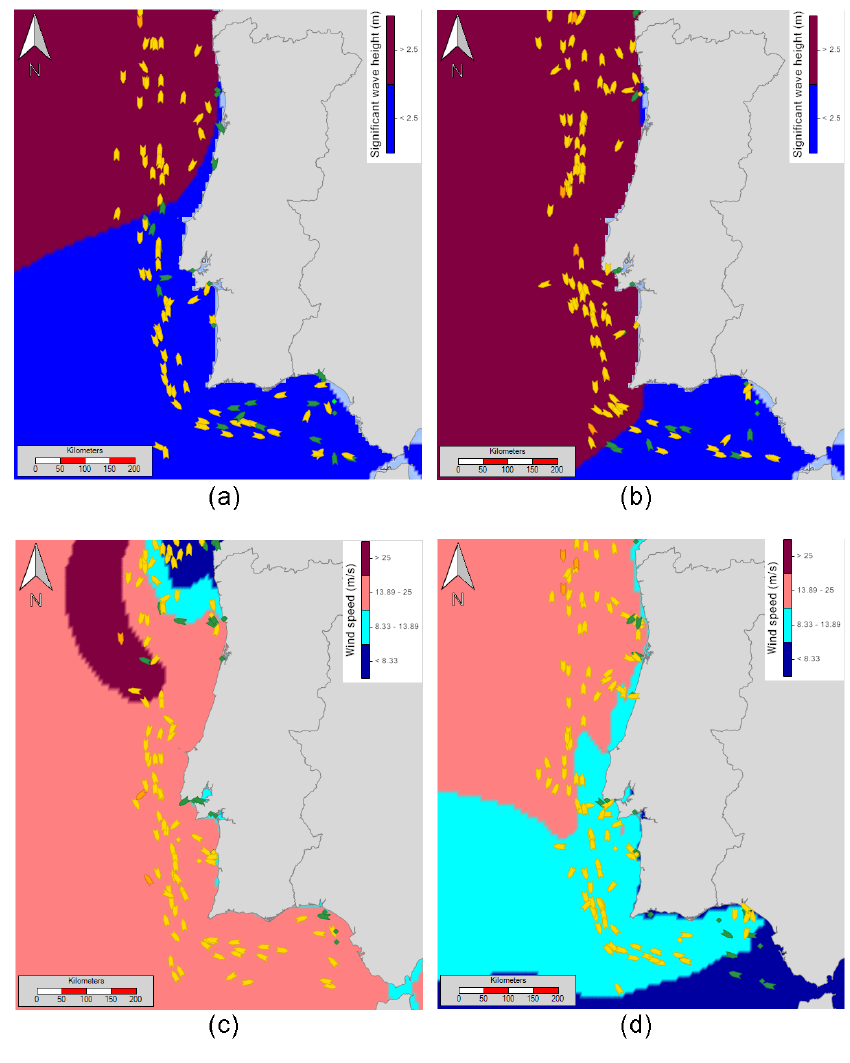
Figure 5. Ship incident risk levels (green ships mean lower risk, yellow means medium risk and orange ships mean higher risk) in the pilot area with background metocean conditions used. ( a and b ) Significant wave height on 18 January 12:00h and 19 January 2013 00:00h respectively; ( c and d ) wind speed on 19 January 06:00h and 22 January 2013 06:00h,